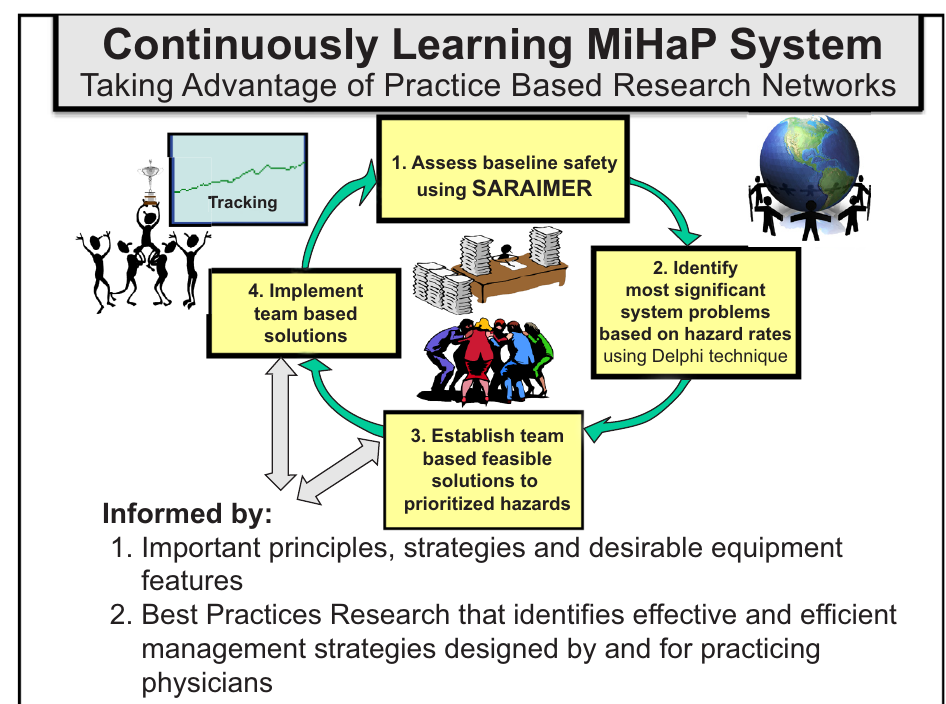
Figure 2. Cyclic SARAIMER-based harm reduction cycle.